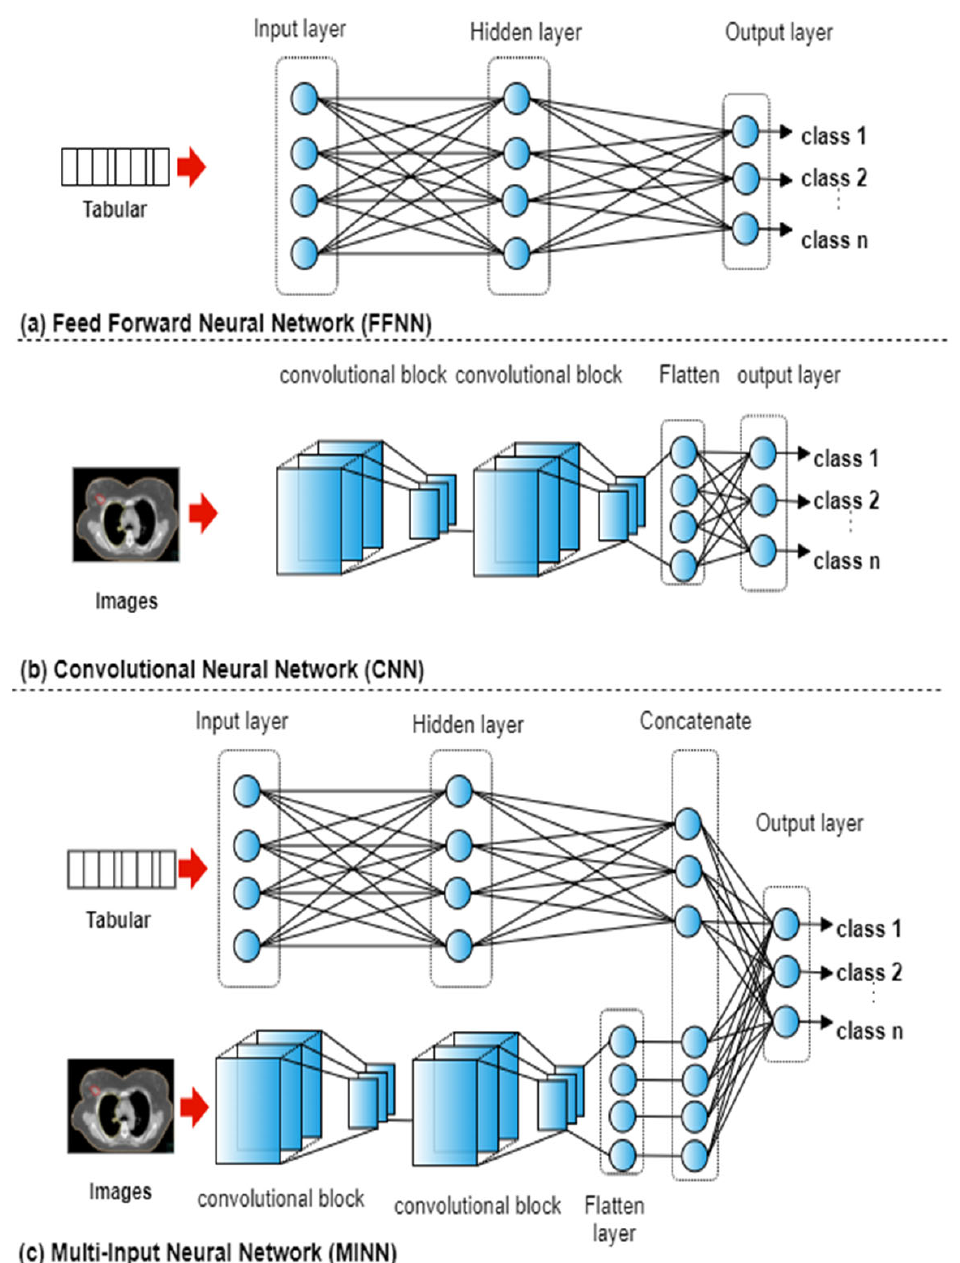
Figure 2. An overview of the utilised neural networks. The network architectures were the same across each of the case studies. The FFNN consisted of three layers with 18 neurons in the hidden layer and sigmoid as the activation function. The CNN consisted of two convolutional blocks (convolutional, pooling, and dropout layers [18]) followed by a flatten layer and an output layer, as shown in Figure 2c. The MINN combined the FFNN and CNN architectures by removing the last layer, adding a concatenation layer followed by an output layer. The ‘softmax’ activation function as used in the output layer with the three architectures. In neural networks with mixed input data, a model f is trained by utilising input features that belong to different categories. The output p of the network is defined